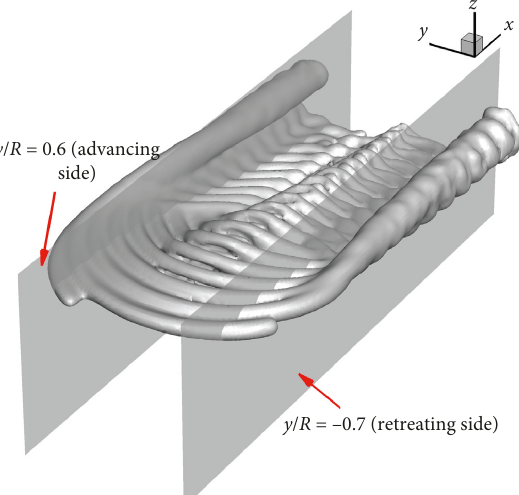
Figure 13: Longitudinal planes for investigation of wake vorticity of ECR.